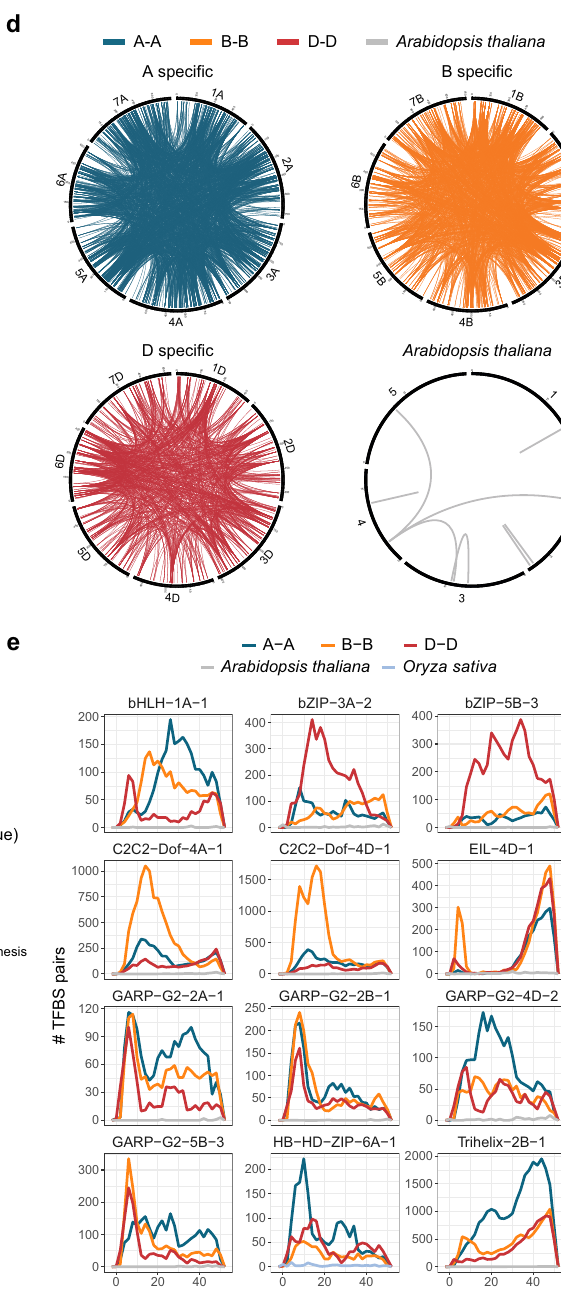
1.5×IQR, points beyond 1.5×IQR past hinge are shown. d Circos plots showing subgenome-speci fi c bHLH-1A-1 TFBS pairs with high sequence similarity (BLASTN E-value <1e-30, identity >70%, and query coverage >70%) within each subgenome; the homolog bHLH28 in Arabidopsis thaliana is shown as a control. For each TF peak set, 400 peaks were randomly selected. e Sequence distance distribution betweensubgenome-speci fi cTFBSswithineachsubgenomeofCSandthoseofthe corresponding TFs in Arabidopsis thaliana (gray line) and Oryza sativa (light blue line). The distance was calculated on the basis of the number of substitutions per 100basesusingtheKimuratwo-parameter(K2P)model 79 .Accordingtothismodel, transitions (purine – purine and pyrimidine – pyrimidine) are more likely than transversions(purine – pyrimidine).Gapsareignored.Sourcedataareprovidedasa Source Data fi